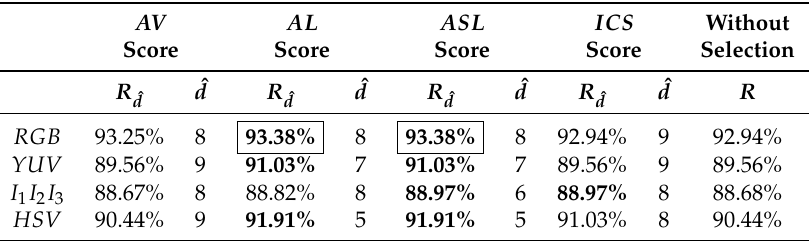
Table 2. Accuracy R ˆ (%) reached with the ˆ d -dimensional selected local binary pattern (LBP) histogram d subspace, according to the different supervised and unsupervised scores on the Outex-TC-00013 set (the dimension of the histogram space is D × Q = 9 × 256 without selection).